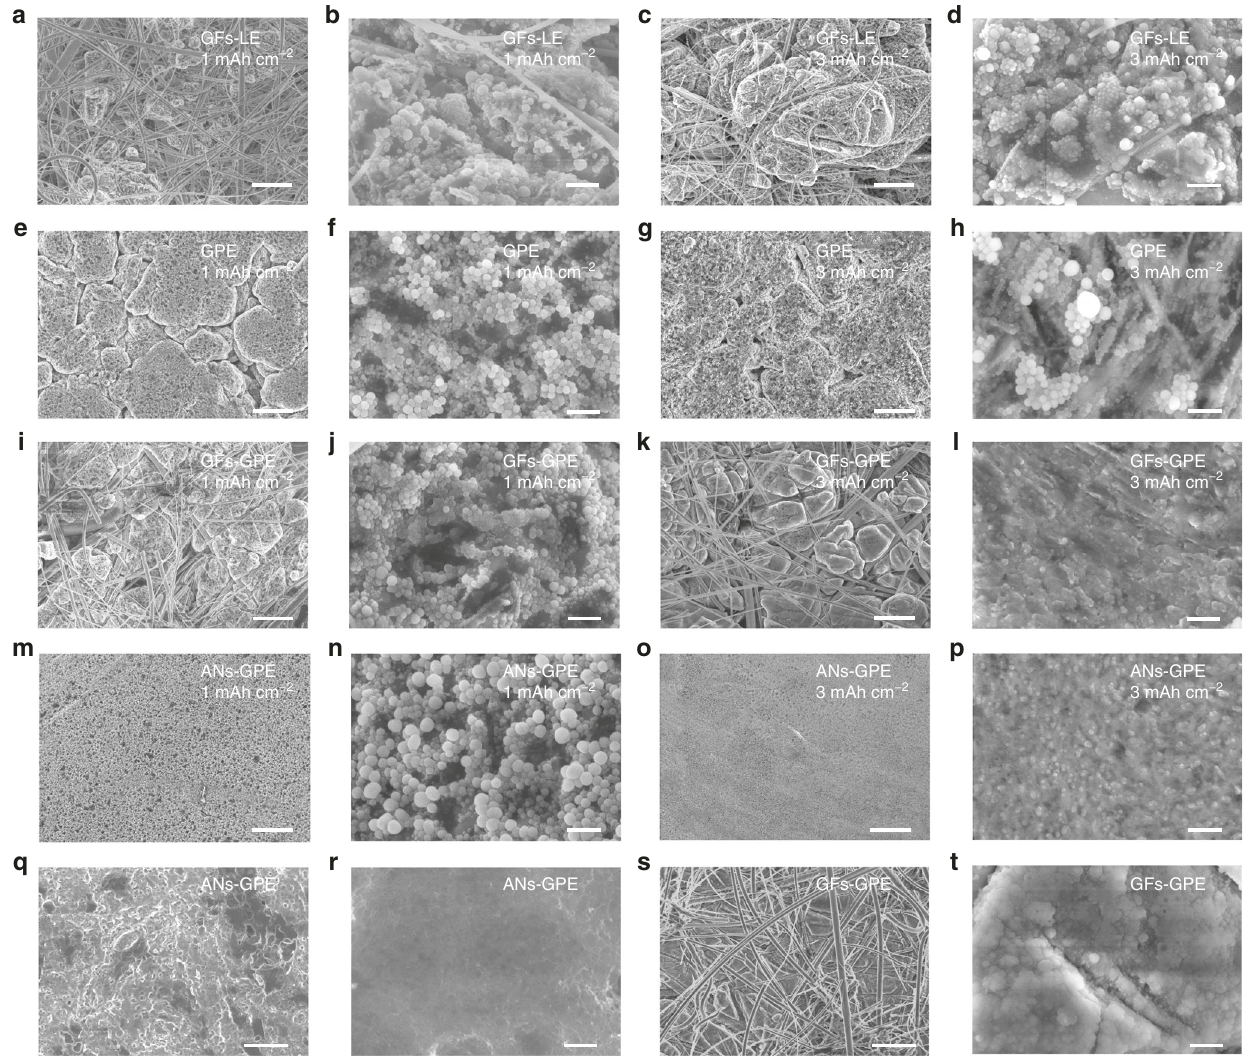
Fig. 4 SEM images of Na metal morphology. Areal capacity of 1 and 3 mAh cm − 2 Na metal was deposited on a Cu surface using GFs – LE ( a , b and c , d ), GPE ( e , f and g , h ), GFs – GPE ( i , j and k , l ) and ANs – GPE ( m , n and o , p ) at current densities of 0.5 mA cm − 2 and 60 °C. The Cu/Na cells using ( q , r ) ANs – GPE and ( s , t ) GFs – GPE were stored at 60 °C for 10 days. The SEM images of Fig. 4b, d, f, h, j, l, n, p, r, t are magni fi ed images of Fig. 4a, c, e, g, i, k, m, o, q, s. Scale bars, 10 μ m in a , c , e , g , i , k , m , o , q , s ; and 500 nm in b , d , f , h , j , l , n , p , r ,